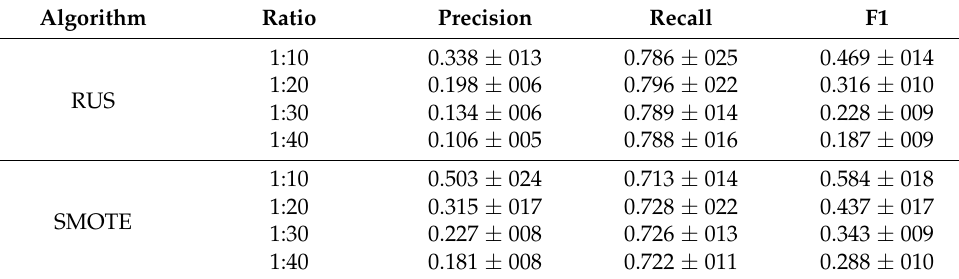
Table 3. Results for the under-sampling and SMOTE methods.